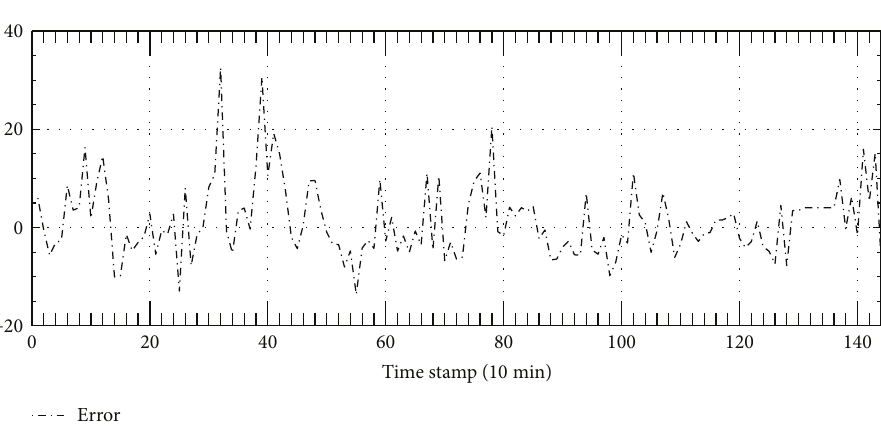
Figure 3: One day ahead RMSE value of wind